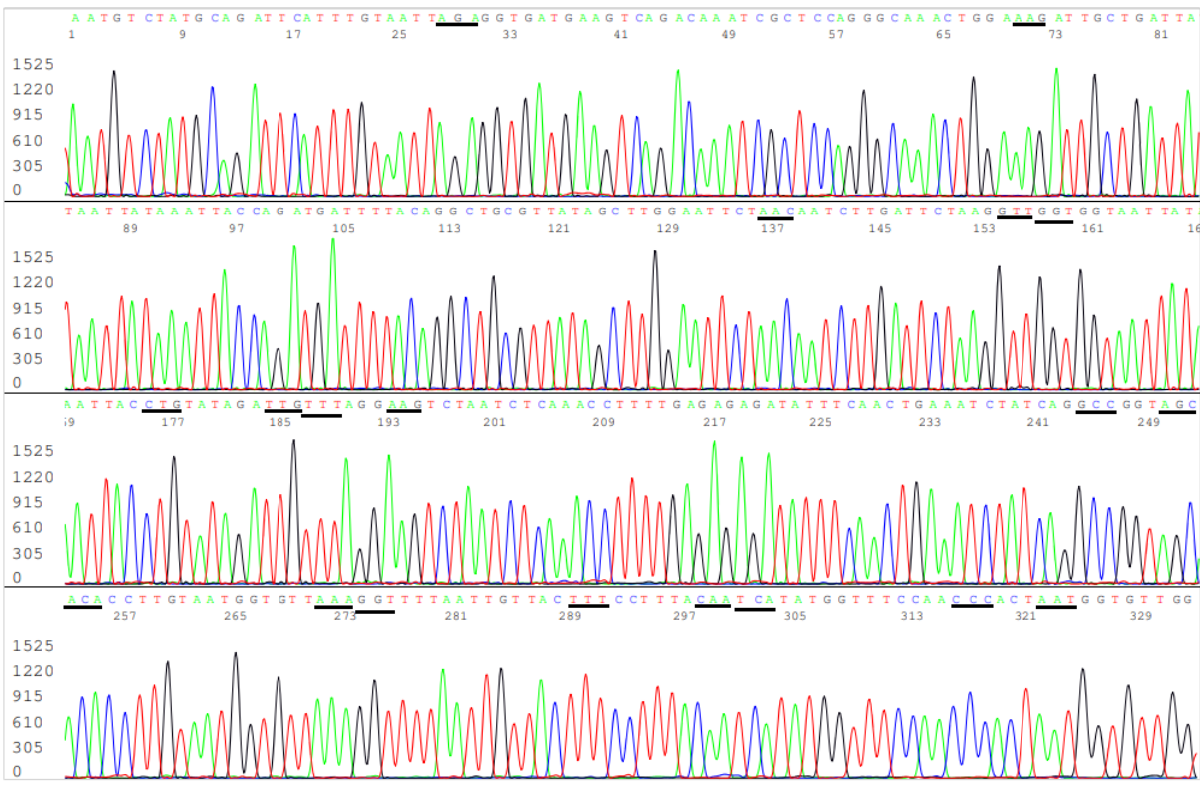
Figure 5. This is a figure of computer-generated electropherogram showing the codons (underlined) of 19 spike protein amino acids in the ACE2 RBD region commonly used to detect and define SARS-CoV-2 variants.